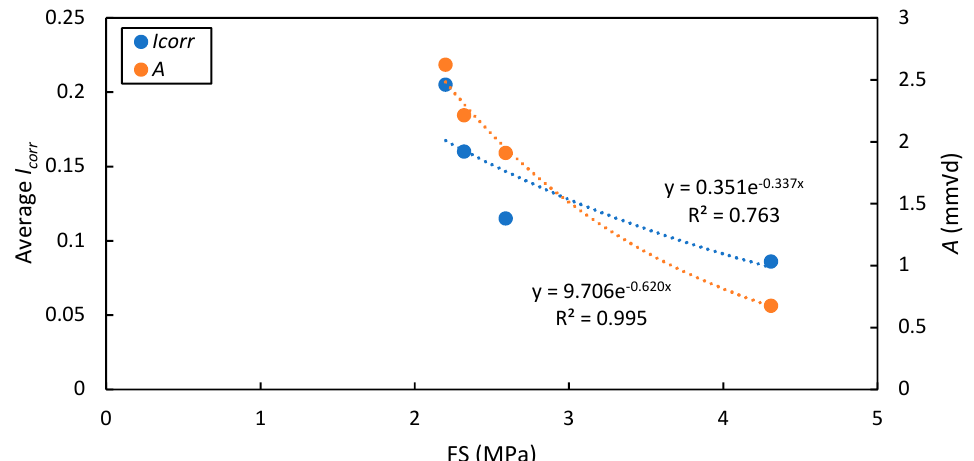
Figure 25. Correlation between the FS and the accelerated durability performance testing (average I corr and A) .